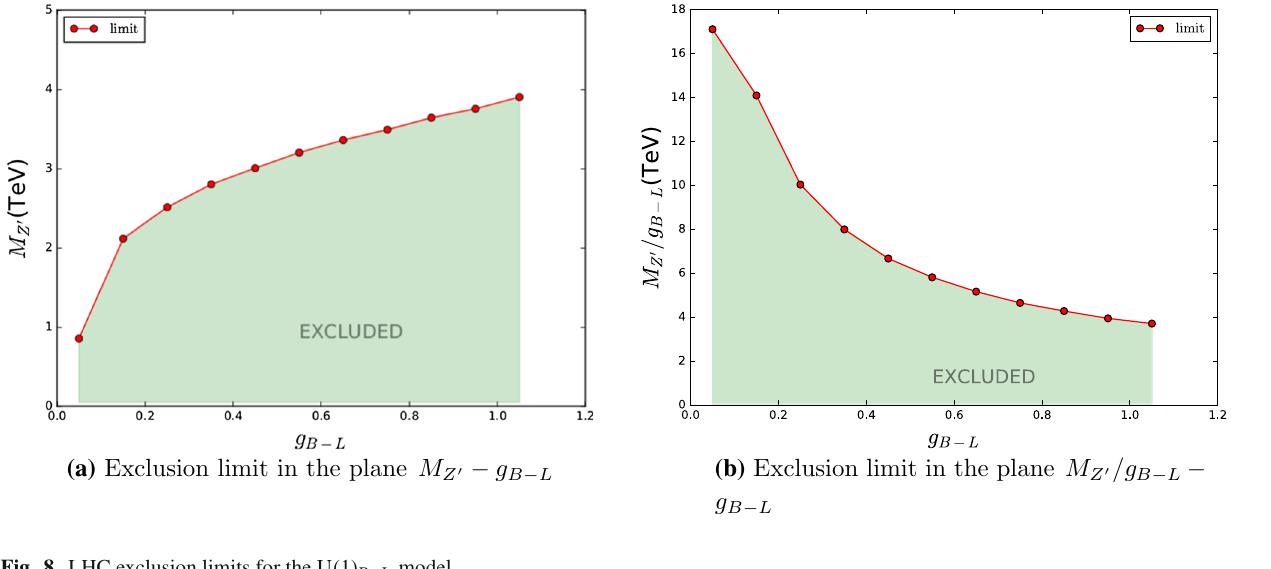
plane M Z (cid:2) vs. g BL , while Fig. 8b shows the same limit in the plane M Z (cid:2) / g BL vs. g BL